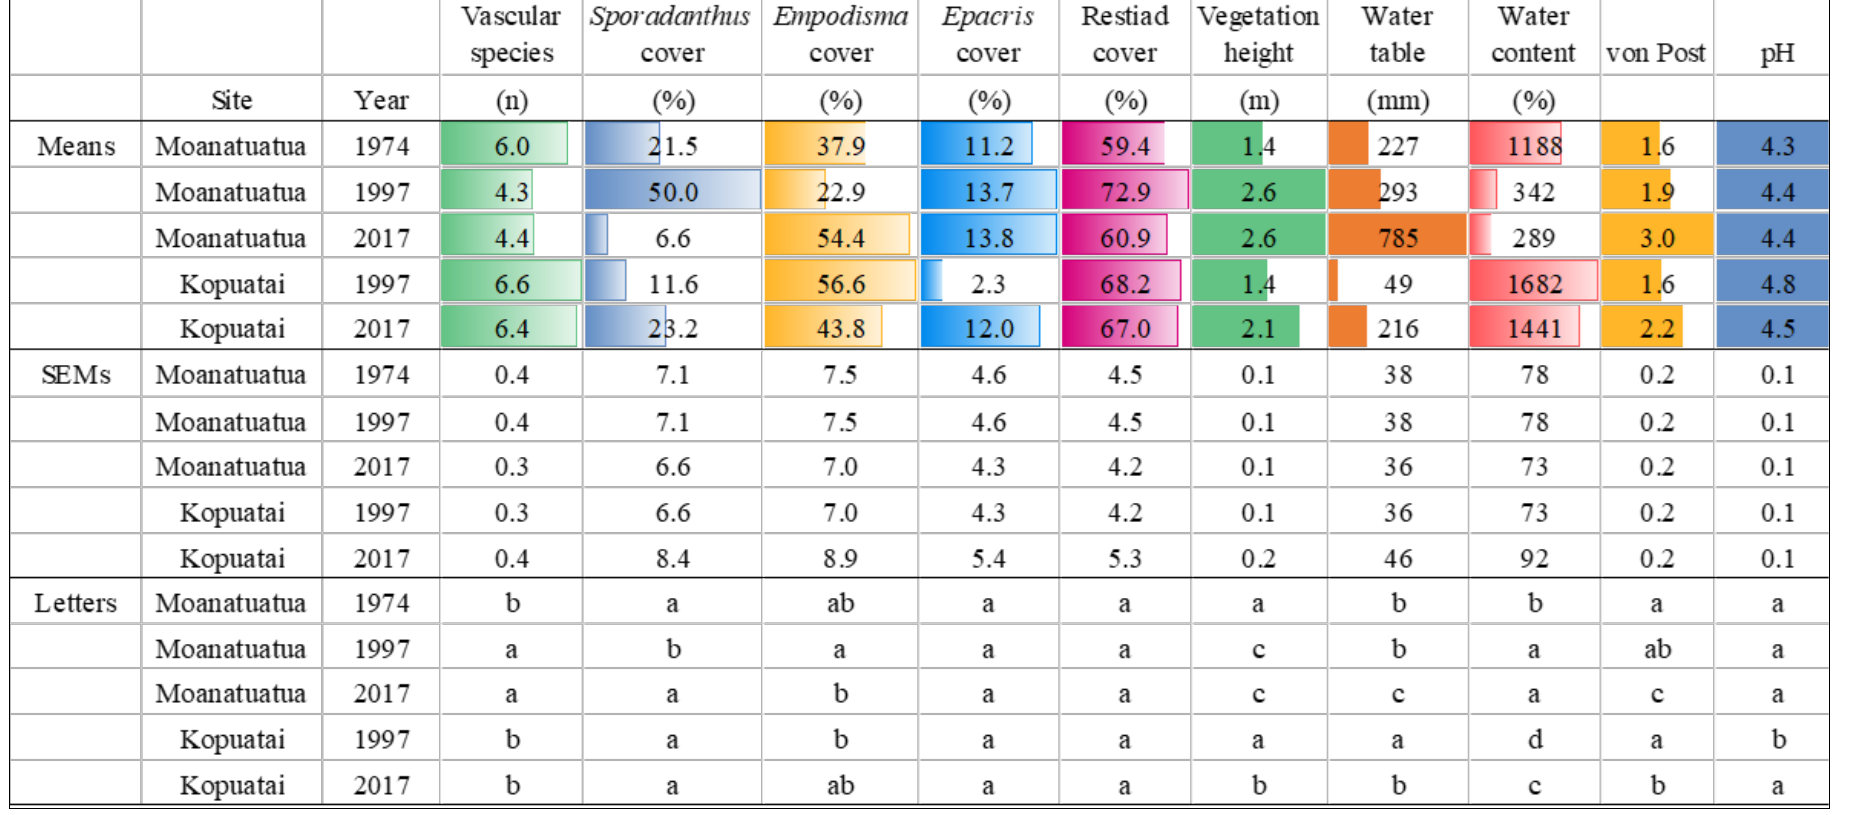
Table 1. Mean vegetation, hydrological and peat physico-chemical properties, from the residual maximum likelihood (REML) analysis, for modified (Moanatuatua) and reference (Kopuatai) bogs in 1974, 1997 and 2017. Water table is depth from bog surface. SEM is standard error of the mean. For each property, means without a letter in common are significantly